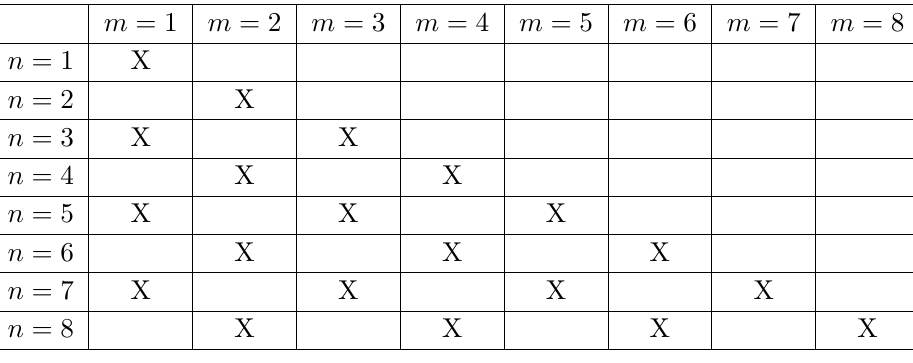
Table 1 . Fourier-modes sin( m σ ) showing up at order ε n in